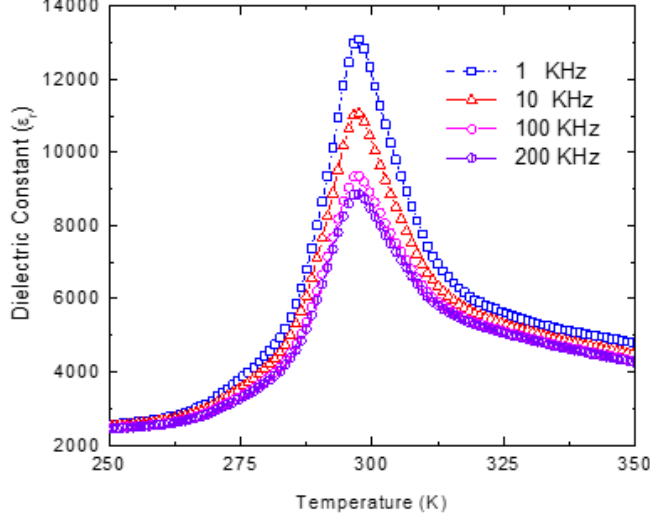
Figure 8. Low frequency dielectric dispersion of PST.